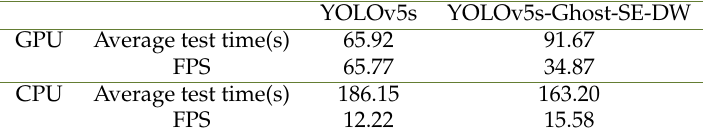
Table 4. BDD100K dataset performance on GPU and CPU